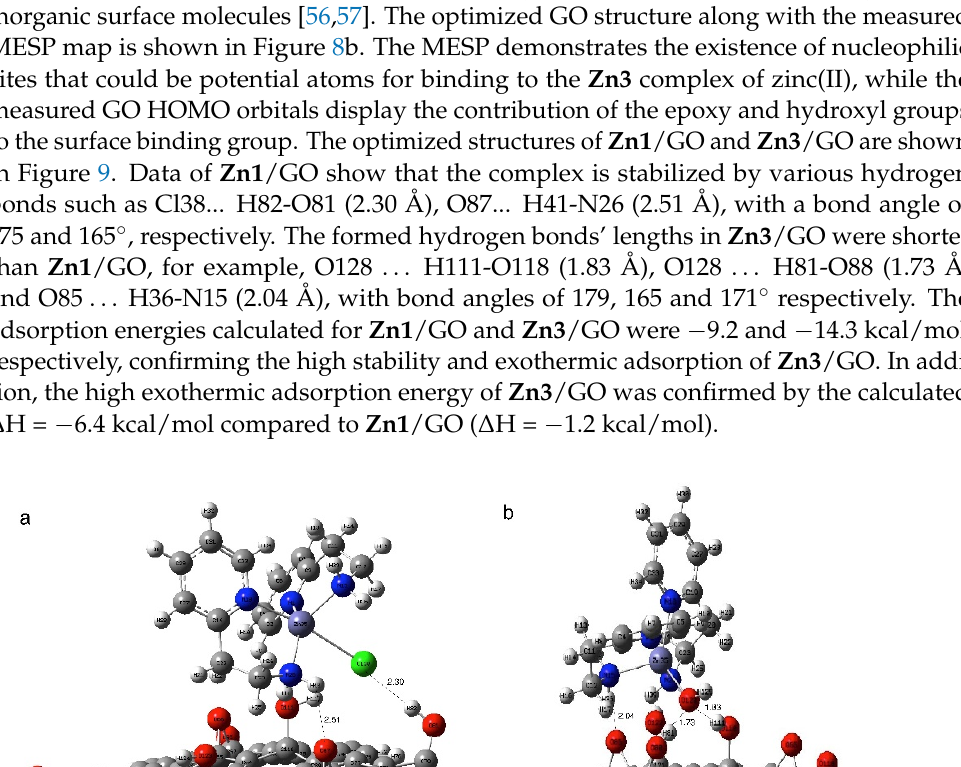
Figure 9. The optimized structure of ( a ) Zn1 /GO and ( b ) Zn3 /GO structures in the gas phase. We investigated the non ‐ covalent interaction (NCI), which largely depends on sur ‐ face electron density, to investigate the existence of molecular interactions for Zn1 /GO and Zn3 /GO structure stabilizations. The 3D isosurface plot visualizes the strength of the noncovalent interactions, where strong NCI such as hydrogen bonding is indicated by the blue region, the green region indicates the weak NCI and the repulsion forces are indi ‐ cated by the red region (Figure 10). In Zn1/GO, the isosurface plot shows the presence of green surface between Cl atom and the H atom for weak HB. On the other hand, the blue region between the O atom of the OH group on the complex and the surface OH groups on the GO surface is illustrated by the Zn3 /GO isosurface, which suggests the develop ‐ ment of strong HB interactions. This finding is confirmed by the short lengths of HB bonds in Zn3 /GO rather than Zn1 /GO.